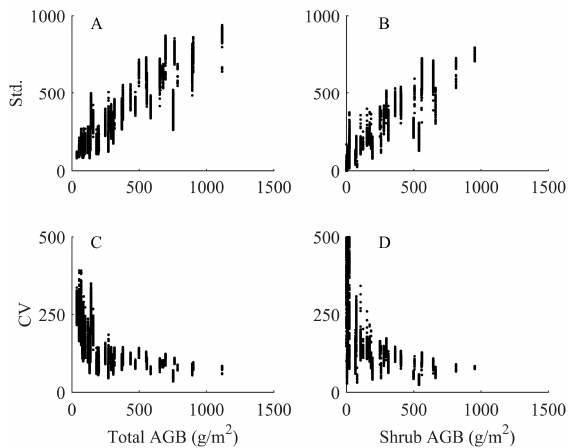
Figure 7. Scatterplots of the imputed biomass values and the standard deviation for total AGB ( A ) and for shrub AGB ( B ) and scatterplots of the imputed biomass values and the coefficient of variation for total AGB ( C ) and for shrub AGB ( D ).